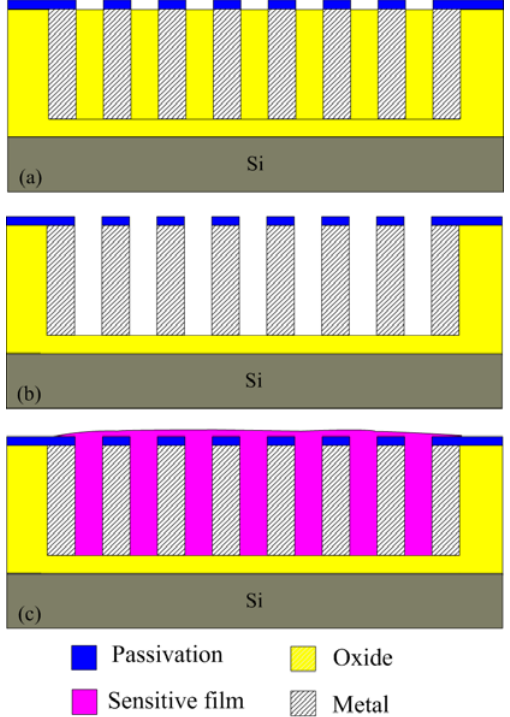
Figure 4. Fabrication flow of the humidity microsensor: ( a ) after the CMOS process,